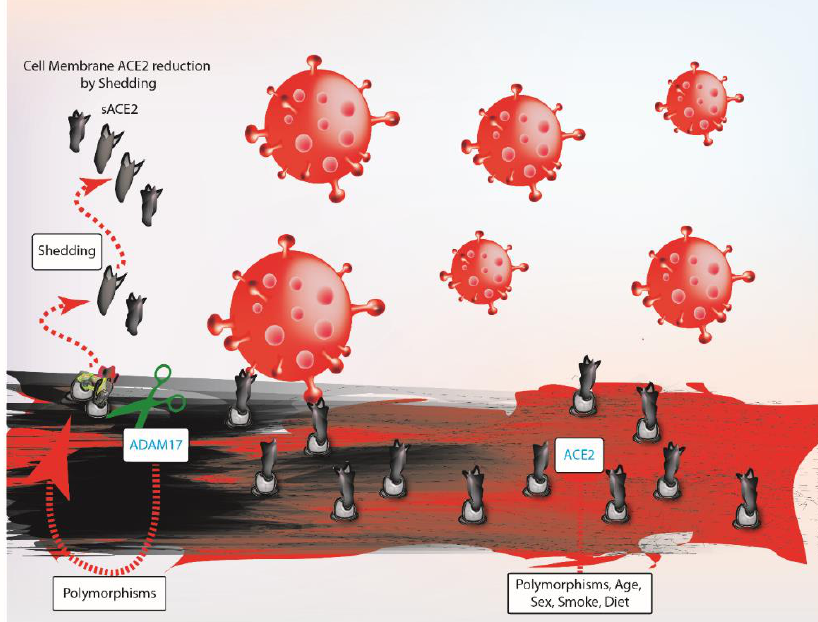
Figure 2. Schematic representation of ADAM17 activity, which efficiency depends on its polymor- phisms. Differences between individuals for ACE2 are influenced by genetics factors coupled with habits such as smoking and diet. Therefore, the reduction of ACE2 availability on cell surface could explain variations in susceptibility among populations. ADAM17, ADAM metallopeptidase domain 17; ACE2, angiotensin-converting enzyme 2; sACE2, soluble ACE2.